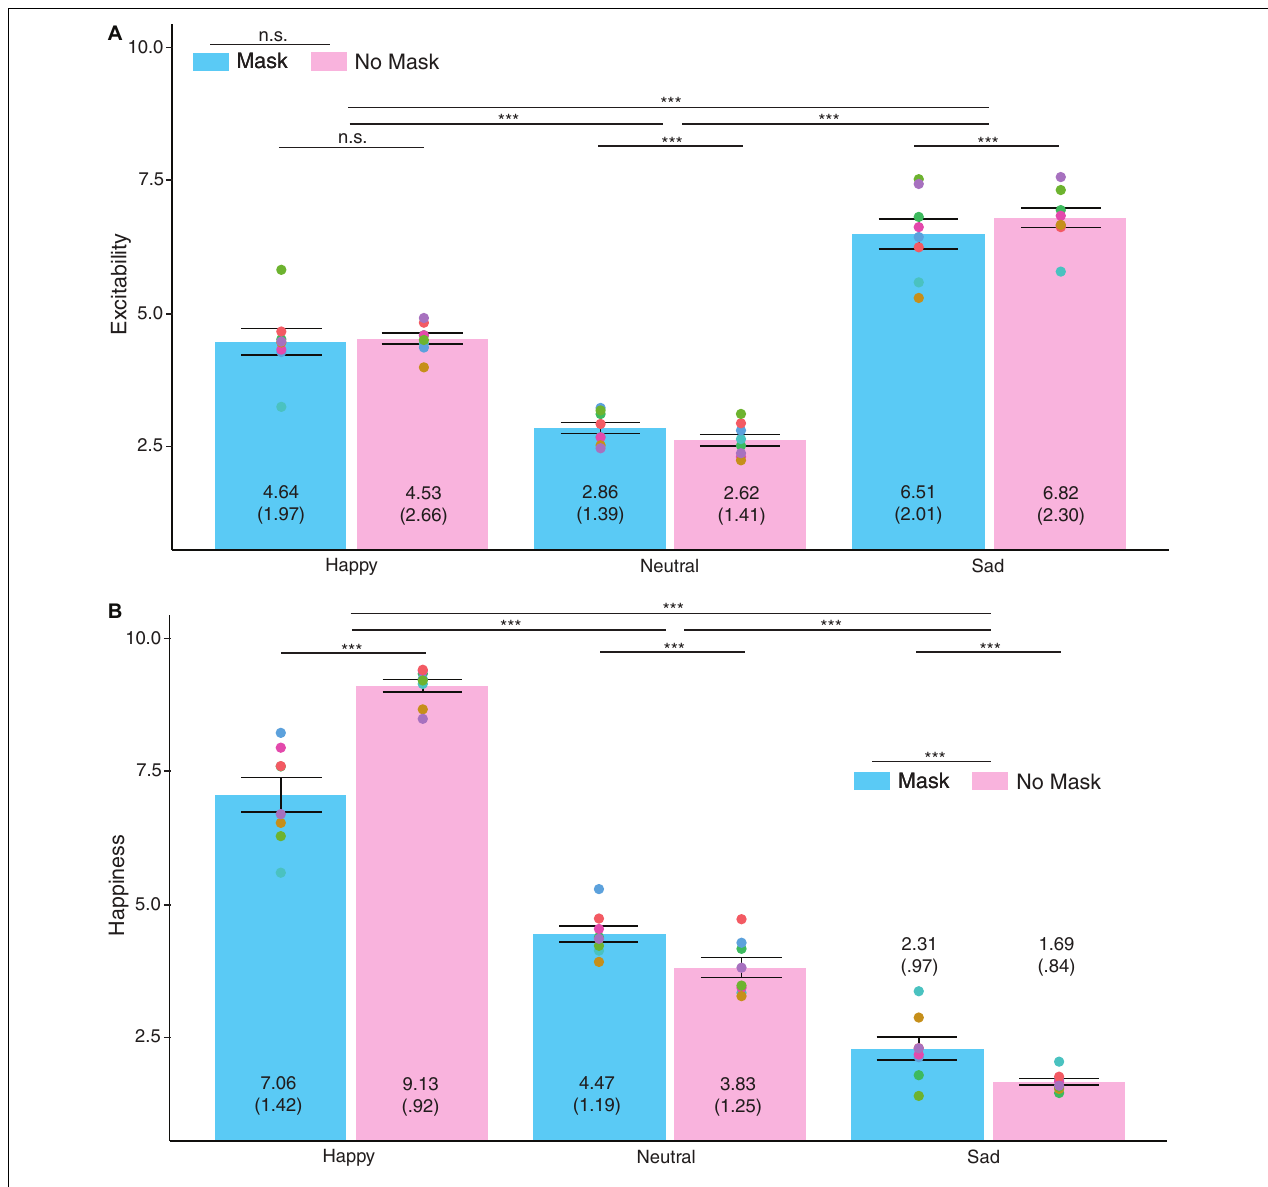
FIGURE 4 | Ratings for emotional expressions of (A) Excitability and (B) Happiness across happy, neutral, and sad faces. Light blue bars represent masked faces and light pink bars represent no-masked faces. Individual points are the averaged rating for each face. The values depicted in each bar are the mean ratings and the standard deviation is in parenthesis. Error bars indicate standard error means (SEM). Higher ratings indicate greater agreement to the perceived emotional expressions. *** p > 0.001, ** p > 0.01, * p >